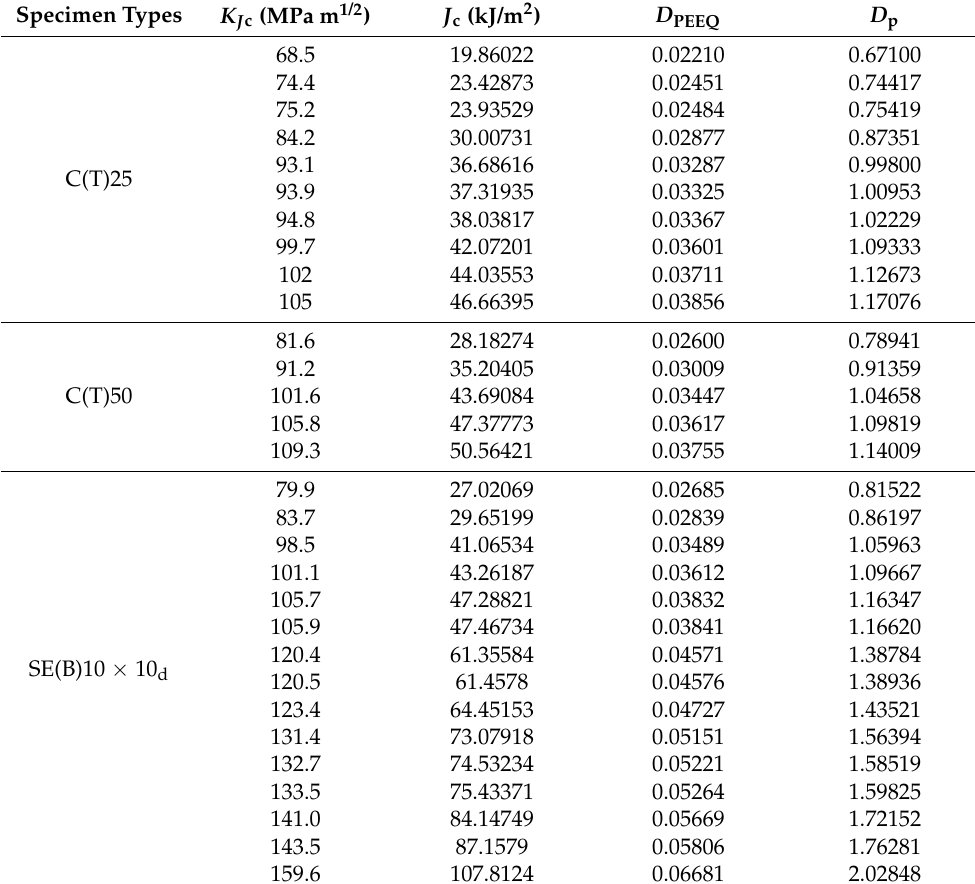
Table 3. Experimental data of fracture toughness [13] and plastic strain gradient calculated by